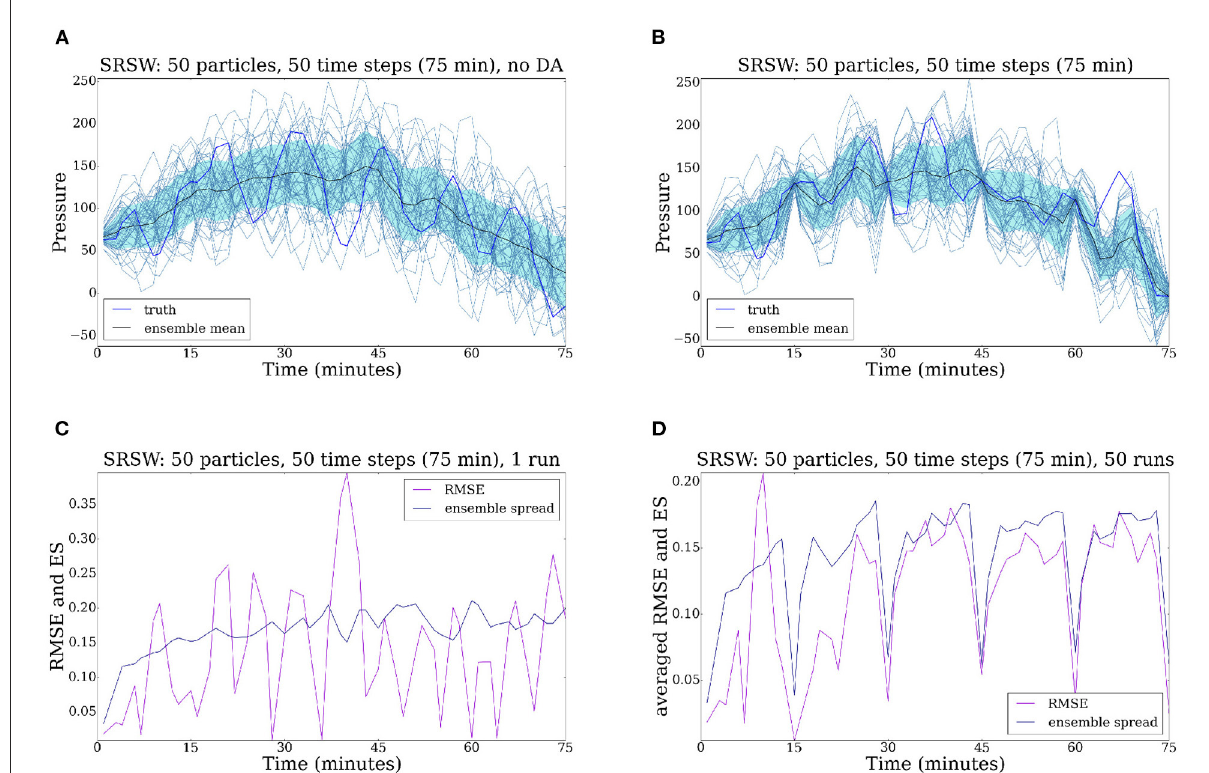
FIGURE9 Evolution of the SRSW model for 50 time steps. Left: no assimilation of data. Right: the system is observed every 10 time steps. (A) Pressure field, no DA. (B) Pressure field. (C) RMSE, no DA. (D)